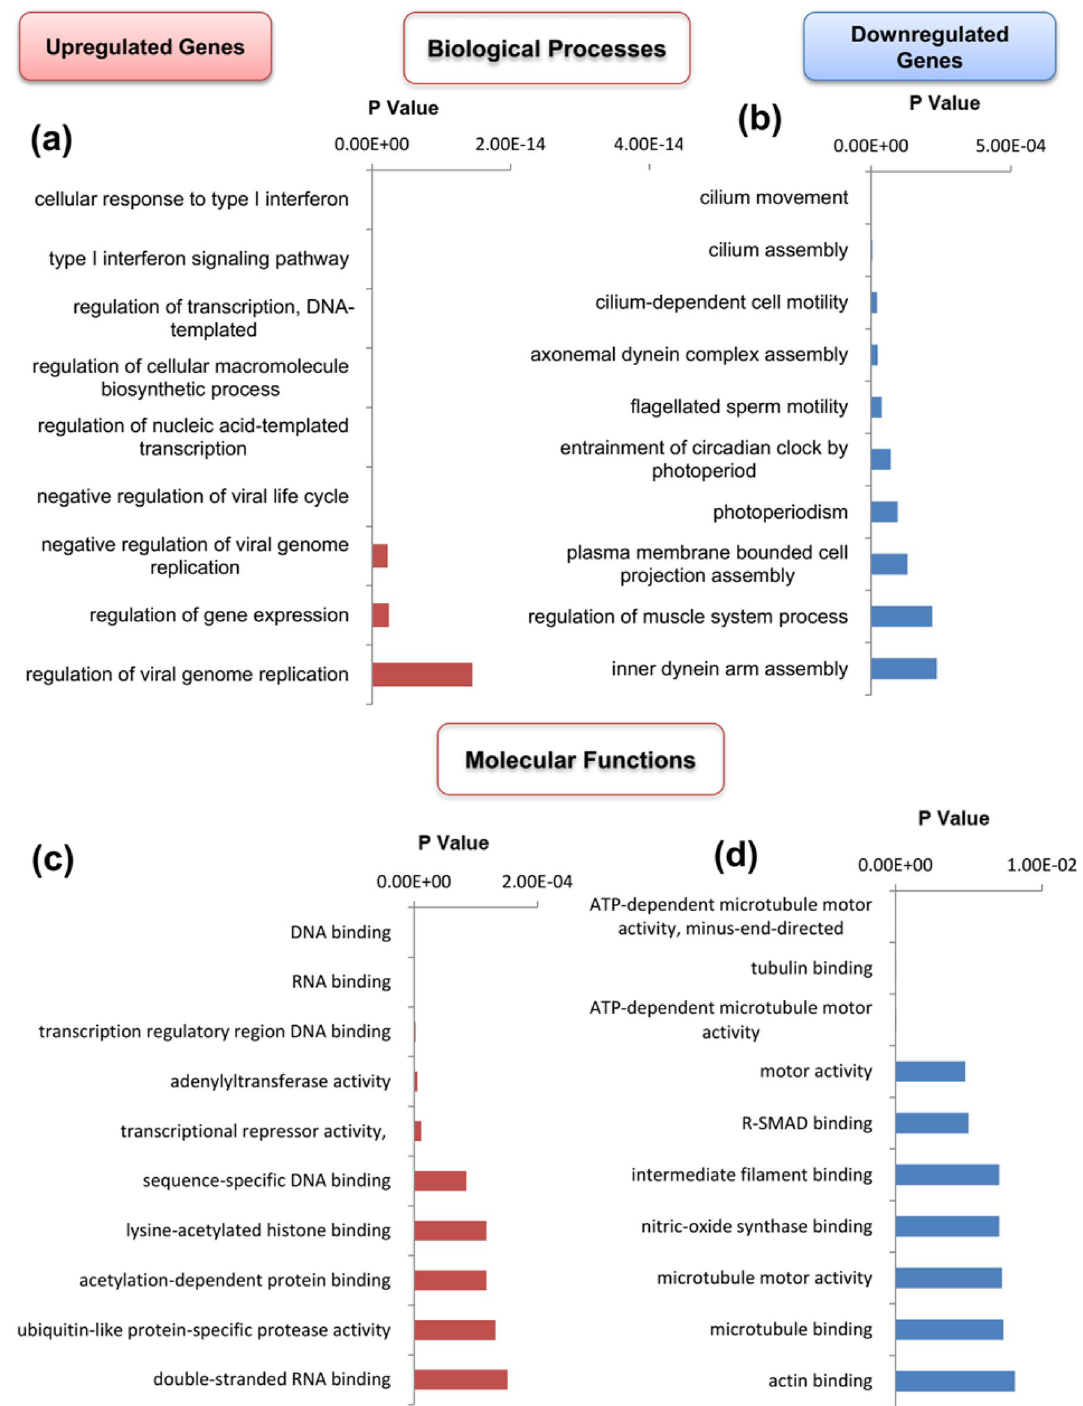
Figure 2. The biological process and molecular function of up/down-regulated DEGs. ( a ) The biological process of up-regulated genes. ( b ) The biological process of down-regulated genes. ( c ) The molecular function of up-regulated genes. ( d ) The molecular function of down-regulated